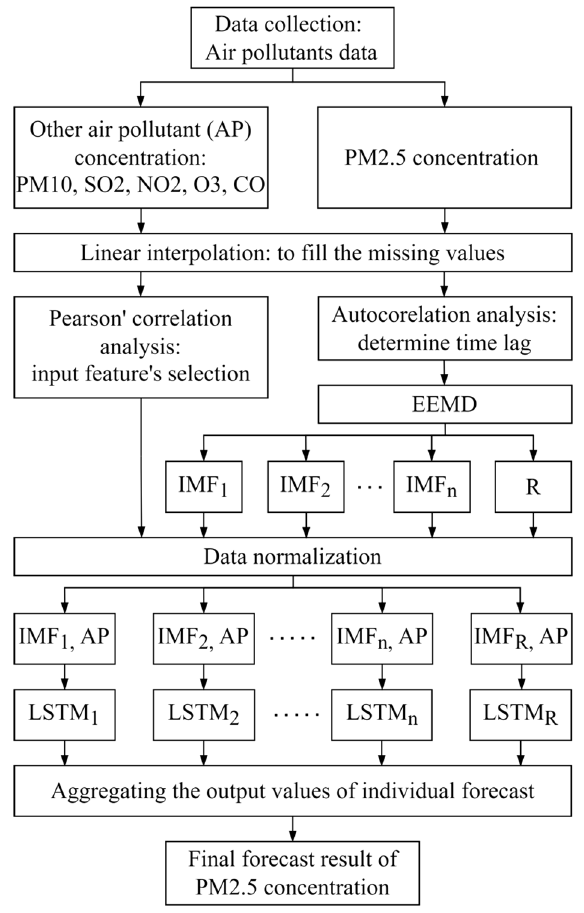
Figure 2. Procedure of